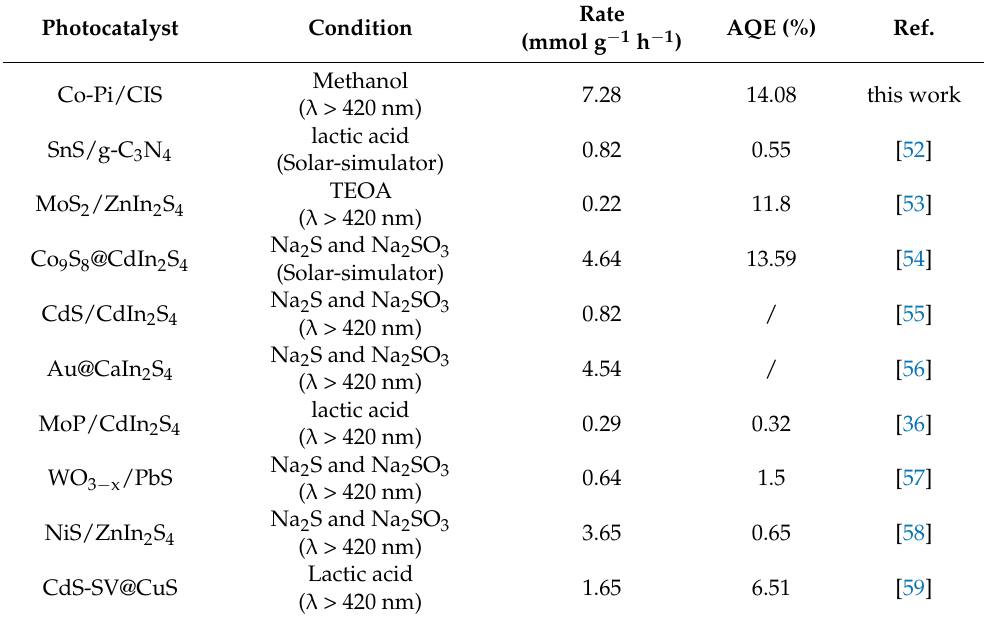
Figure 3. ( a ) Photocatalytic H 2 evolution over CIS, Co-Pi/CIS and Pt/CIS under visible light irradiation, ( b ) photocatalytic H 2 evolution rate of CIS and x% Co-Pi/CIS, ( c ) wavelength dependence of apparent quantum efficiency (AQE) and the absorption spectra of Co-Pi/CIS, and ( d ) cyclic photocatalytic H 2 production property of Co-Pi/CIS. Table 1. Comparison of representative sulfide photocatalysts and their H 2 evolution behaviors.